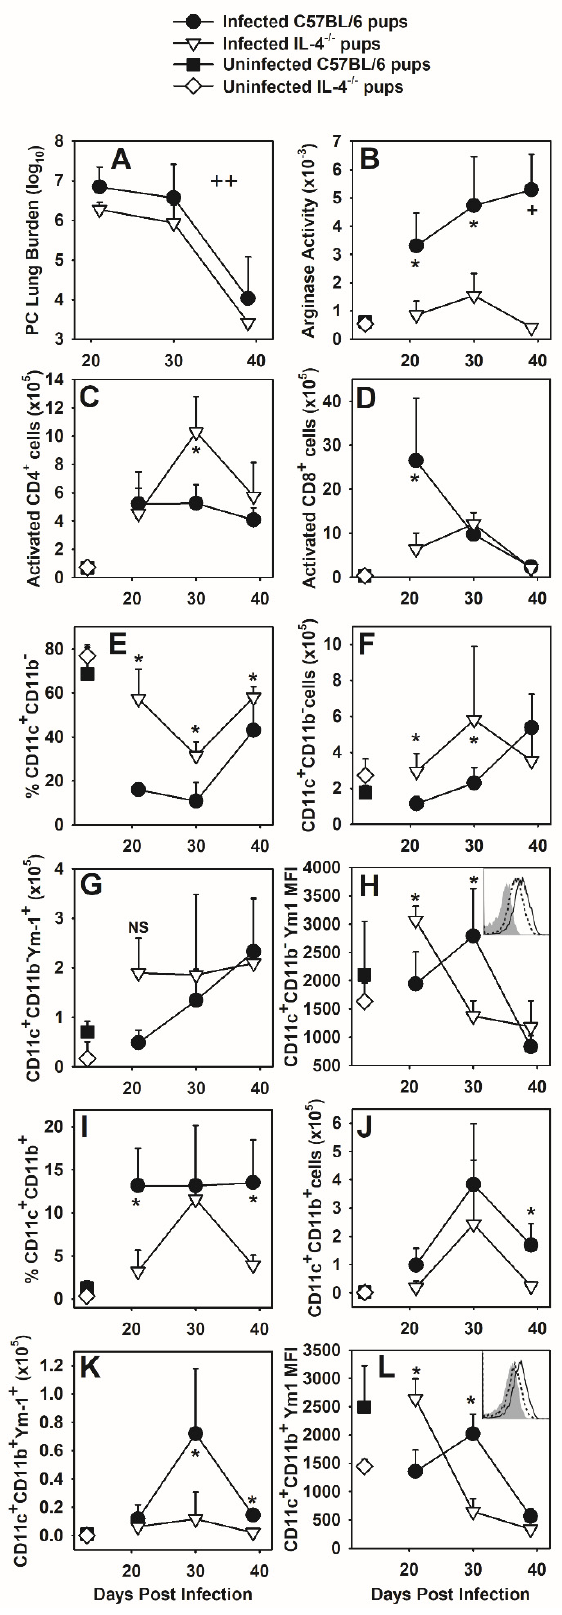
Figure 4. IL-4 dampens the CD4 + T cells response to P. murina in neonatal mice. Two-day old C57BL/6 and IL-4 − / − pups were infected with P. murina organisms. At indicated days post infection, BALF and lungs were collected from 4-7 mice per group. ( A ) P. murina lung burden was determined